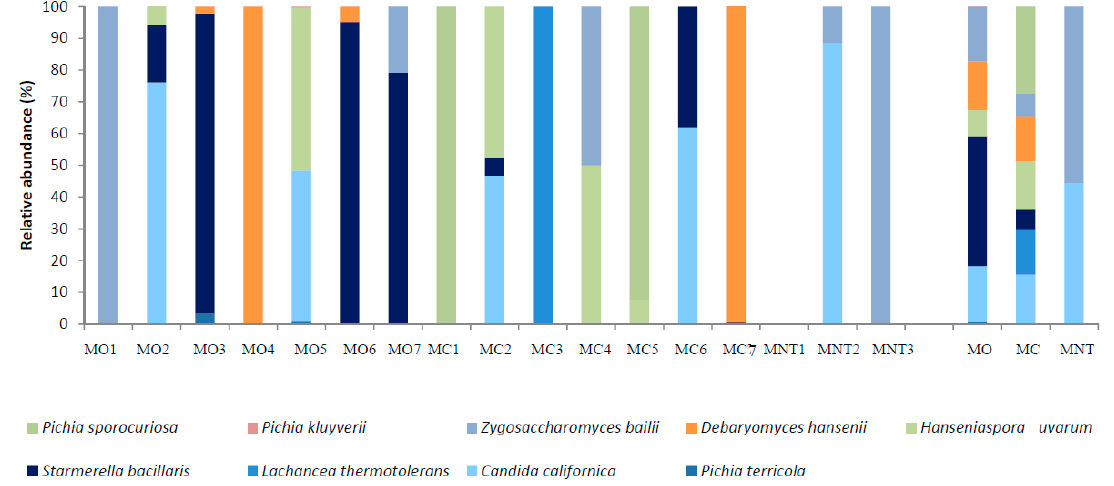
Figure 7. Relative abundance of yeast species detected by culture-dependent method at the 15th day of spontaneous fermentation in organic (MO), conventional (MC) and not treated (MNT) samples. The number associated to the samples represent the replicates for each treatment. To the right of the graph, mean values of each treatment are represented (MO, MC and MNT).